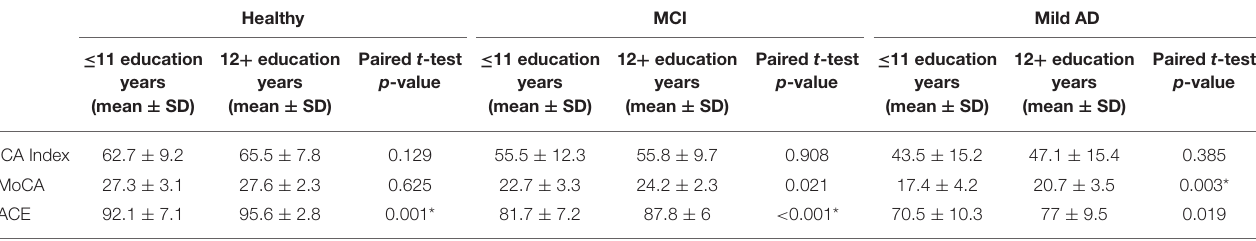
TABLE 2 | Mean and standard deviation of ICA, MoCA, and ACE scores broken down by education years. Healthy MCI Mild AD